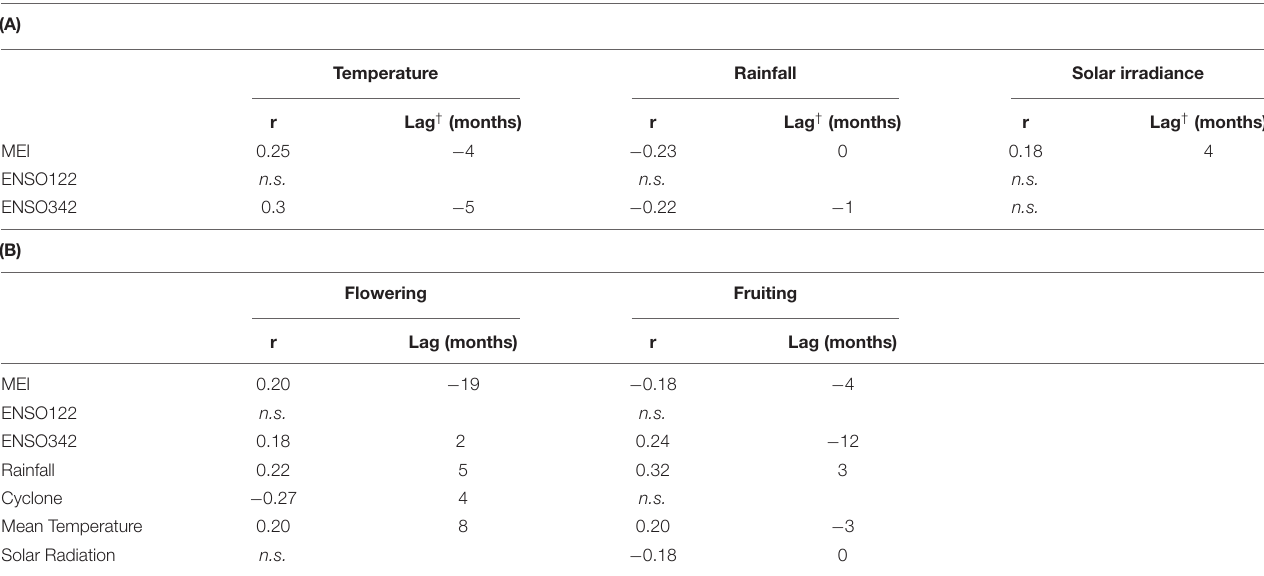
TABLE 1 | Cross correlations among monthly values of flowering and fruiting activity (percentage of subplots showing phenological activity) on Barron Gorge National Park, Far North Queensland; (A) Between three indices of the El Niño Southern Oscillation and climate variables (rainfall, mean temperature, and solar irradiance) recorded the study area, and (B) Between climate variables, including El Niño Southern Oscillation index and cyclone, and phenological activity (flowering and